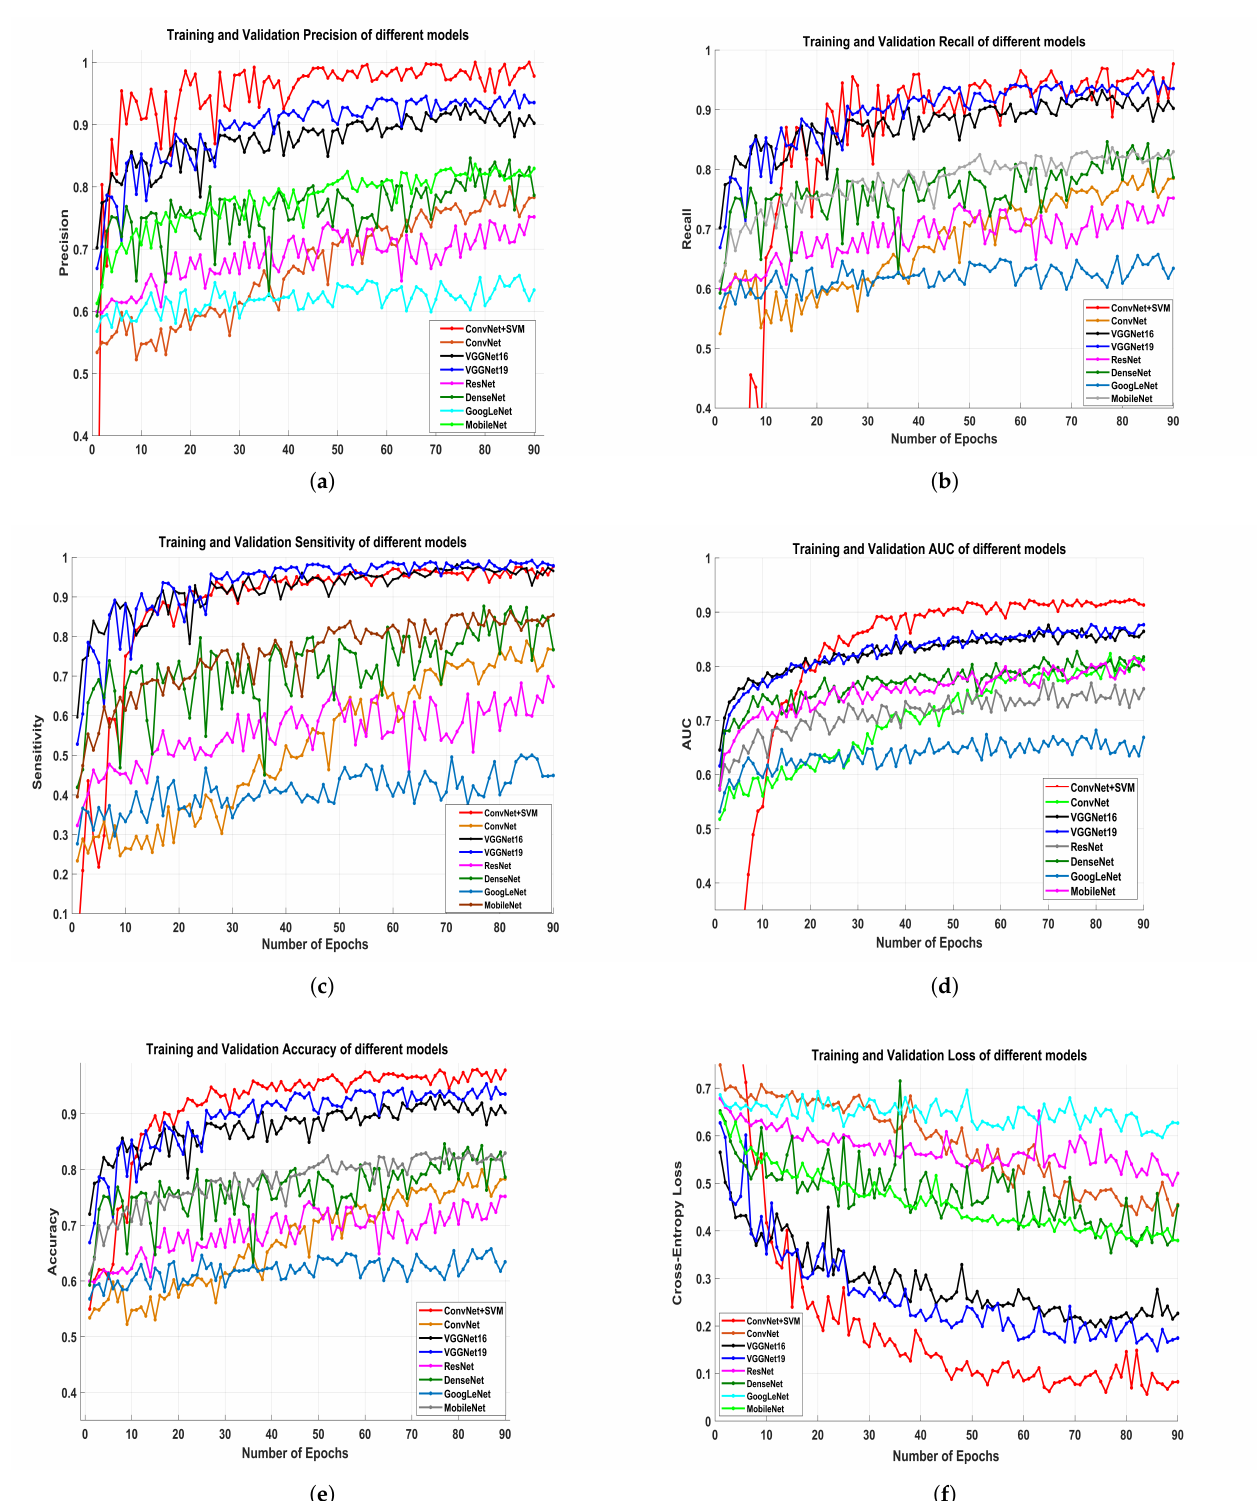
Figure 9. The figures elaborates the performance evaluation of presented models ConvNet+SVM, ConvNet, VGGNet16, VGGNet19, ResNet50, GoogLeNet, DenseNet121, MobileNetV2 in term of the training and validation precision ( a ), recall ( b ), sensitivity ( c ), AUC ( d ), accuracy ( e ), and cross-entropy loss ( f ) against the 90